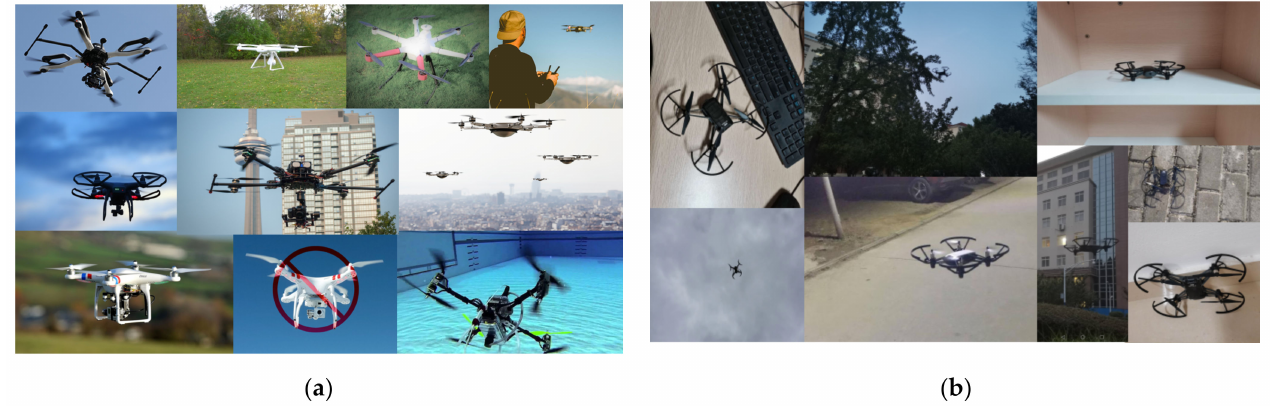
Figure 9. Images of UAV dataset. ( a ) UAV images downloaded from the network. ( b ) UAV images taken by a mobile